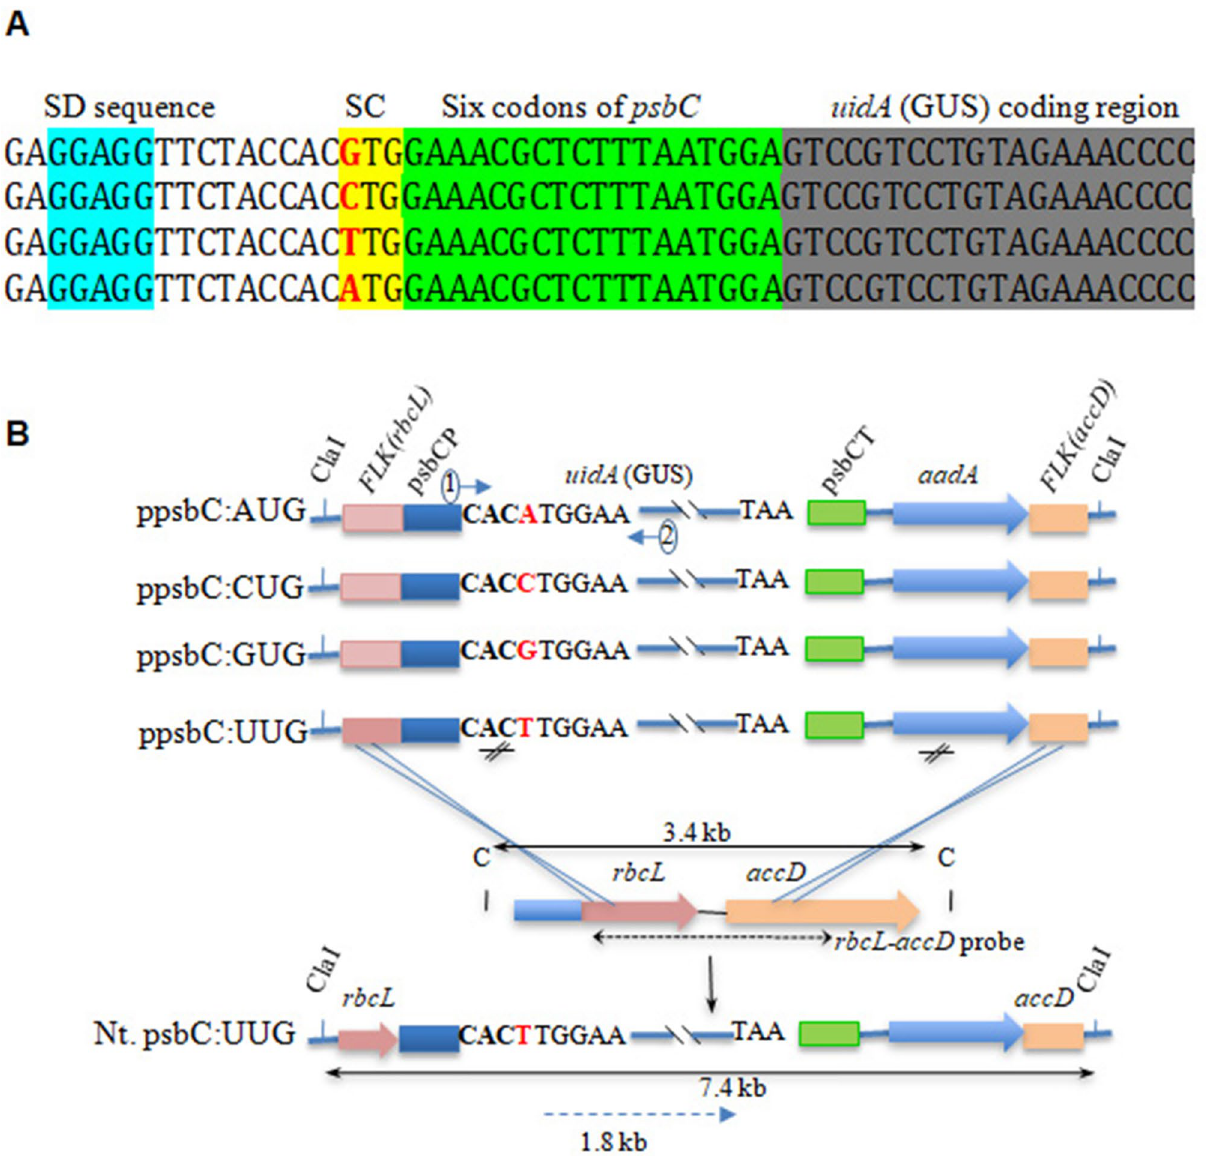
Figure 1. Schematic representation of expression cassettes used for chloroplast transformation. ( A ) Partial sequence of uidA (GUS) gene fused in frame with psbC gene 5 ′ untranslated region (5 ′ UTR). SD and SC represent Shine–Dalgarno sequence (blue) and start codon (yellow), respectively. The first six codons (following start codon) are highlighted in green. ( B ) Partial restriction map showing the chimeric genes uidA and aadA . Also shown is the site of wild-type tobacco plastome where the chimeric uidA and aadA genes are expected to be integrated into the chloroplast genome (crossed lines) and the resulting transplastome with restriction sites and anticipated size of DNA fragments (solid line with double arrow) when restricted with ClaI restriction enzyme. Nt., psbCP, psbCT, FLK( rbcL ), FLK( aacD ) represent Nicotiana tabacum, psbC promoter, psbC terminator, partial sequences from rbcL and accD genes as flanking sequences (FLK) on either side of the transgene cassettes, expected ~ 2.1 kb major band representing uidA transcript 28 , the presence of a minor band of lower size was also observed in all transplastomic lanes, which might represent the uidA transcripts that are not denatured com- pletely at the time of gel loading. However, uidA transcript levels were significantly less where CUG was used as the start codon. To rule out any unequal loading of total RNA in the gel, the same blot was reprobed using the 16S rRNA sequence, and the results showed that RNA was loaded equally in all four lanes (Fig. 2D). Role of sequence context flanking start codon in transcription and translation. To assess the influence of the sequence around the start codon on transcription and protein synthesis, another set of four constructs was developed where uidA was placed under the heterologous rice chloroplast psbA promoter (Supplementary Fig. S1) 29 with different start codons (AUG, GUG, CUG and UUG) and stably transformed